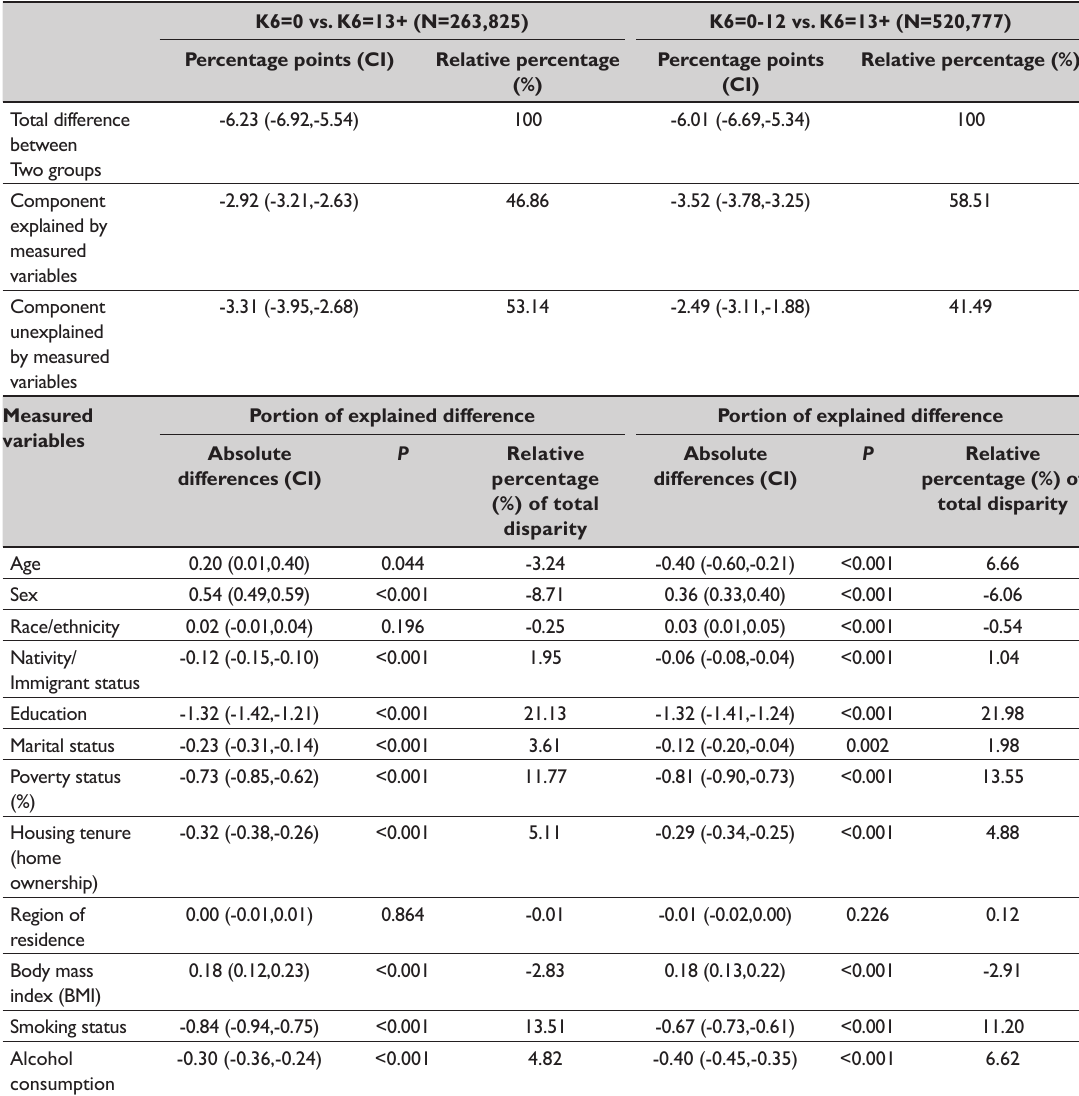
Table 5: Blinder-Oaxaca linear decomposition results for disparities in all-cause mortality between adults with SPD (K6=13+) and adults with no PD (K6=0) and between adults with SPD (K6=13+) and adults with no SPD (K6=0-12), United States,